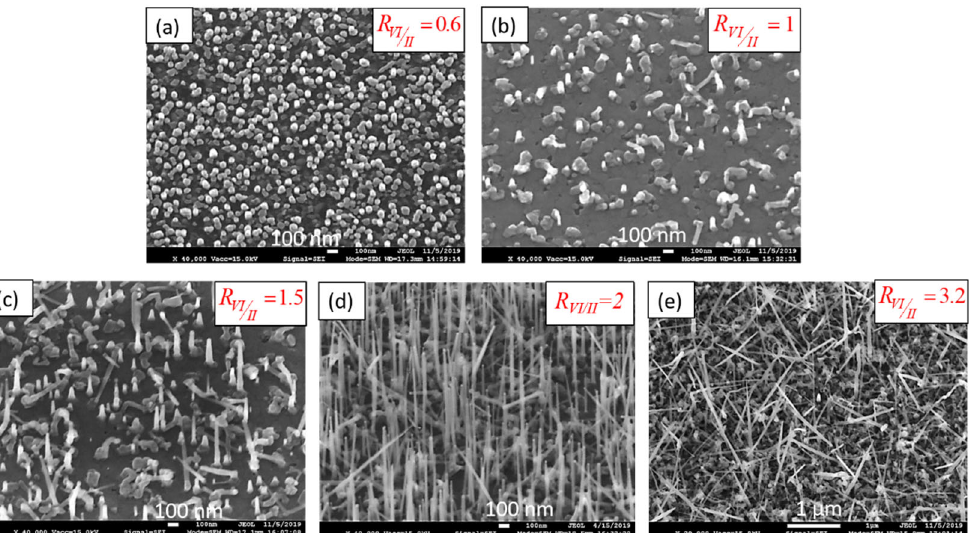
Figure 6. 45° tilted SEM images of ZnS NWs with various VI ‐ II ratio ( a ) 0.6, ( b ) 1, ( c ) 1.5, ( d ) 2, and ( e ) 3.2. and ( e )